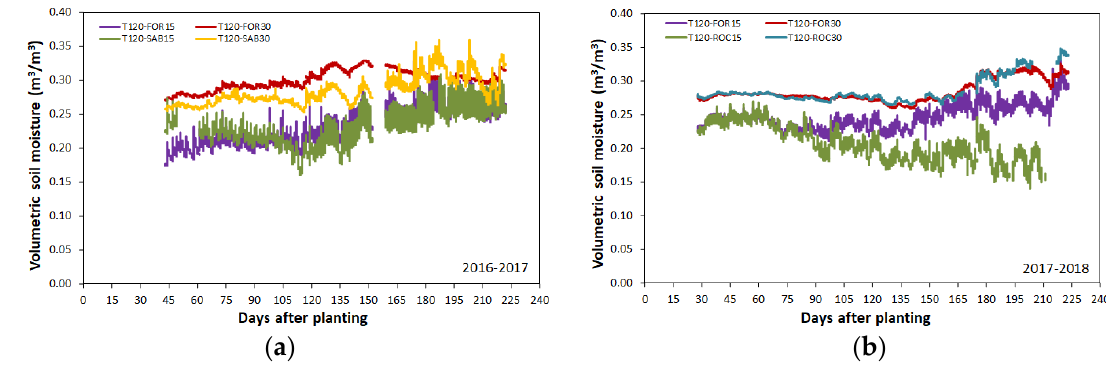
Figure 2. Variation of soil water content measured by 10HS probes on the top 15 and 30 cm of the T120 water treatment during ( a ) 2016–2017 in ‘Fortuna’ (T120-FOR15 and T120-FOR30) and ‘Sabrina’ (T120-SAB15 and T120-SAB30), and ( b ) 2017–2018 in ‘Fortuna’ and ‘Rociera’ (T120-ROC15 and T120-ROC30).